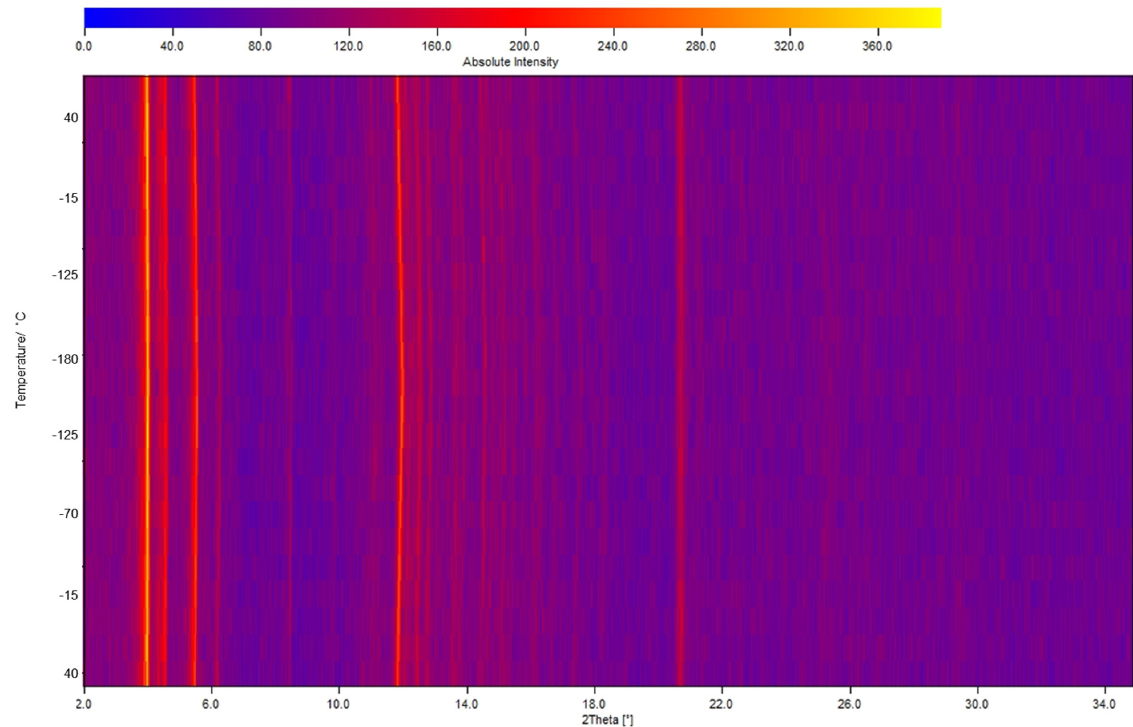
Figure 7. 3D graphic illustration of the powder XRD VT series ( λ = 0.7093 Å), the temperature goes from 40 °C to − 180 °C and back to 40 °C.